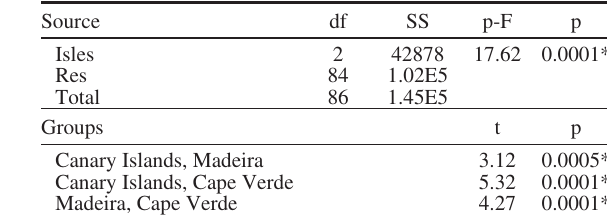
Table 2. – Results of the PERMANOVA analysis. *values indicate significant differences at p<0.05; df, degrees of freedom; SS, sum of squares; p-F, pseudo F value; p, p value; t, t value.